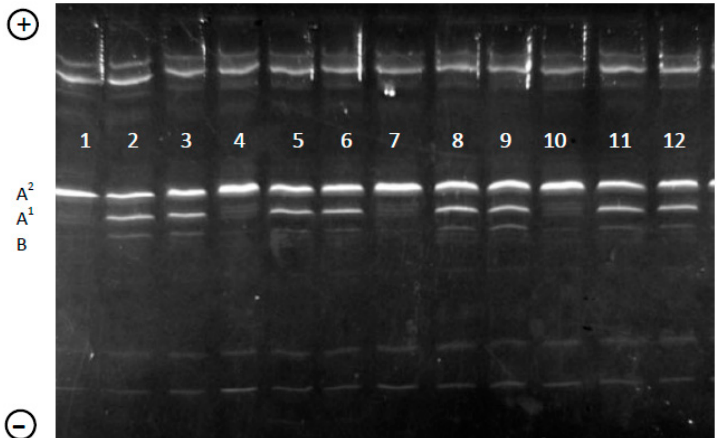
Figure 3. IEF analysis of bulk milk samples. Samples 1, 4, 7, and 10 are from A2 milk. The positions of the three most common β -CN variants (A 1 , A 2 and B) are indicated on the left side of the gel. In the upper (+) and lower ( − ) part of the gel α S1 -CN and κ -CN are visible, respectively.